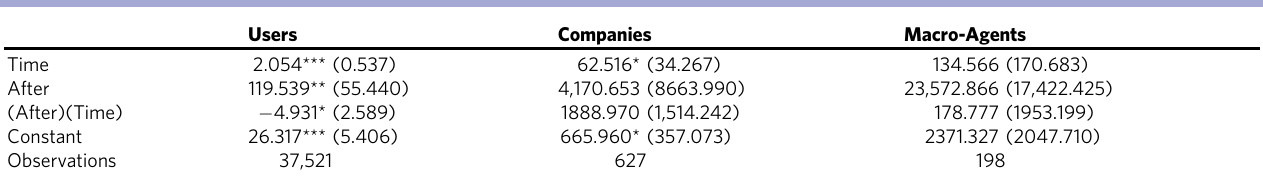
Table 3. Total dollars exchange — 90-day spans.